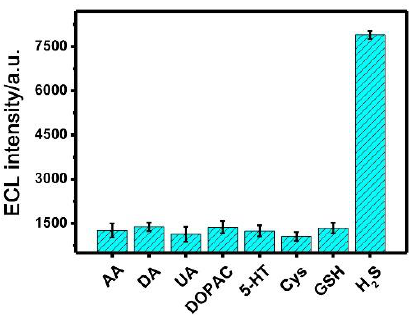
Figure 5. Selectivity of the proposed ECL biosensor for H 2 S detection.